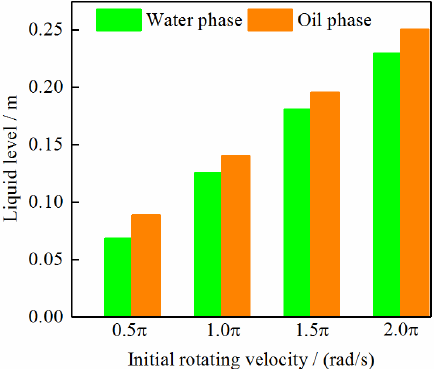
Figure 4. Liquid height at the vortex critical penetration state.